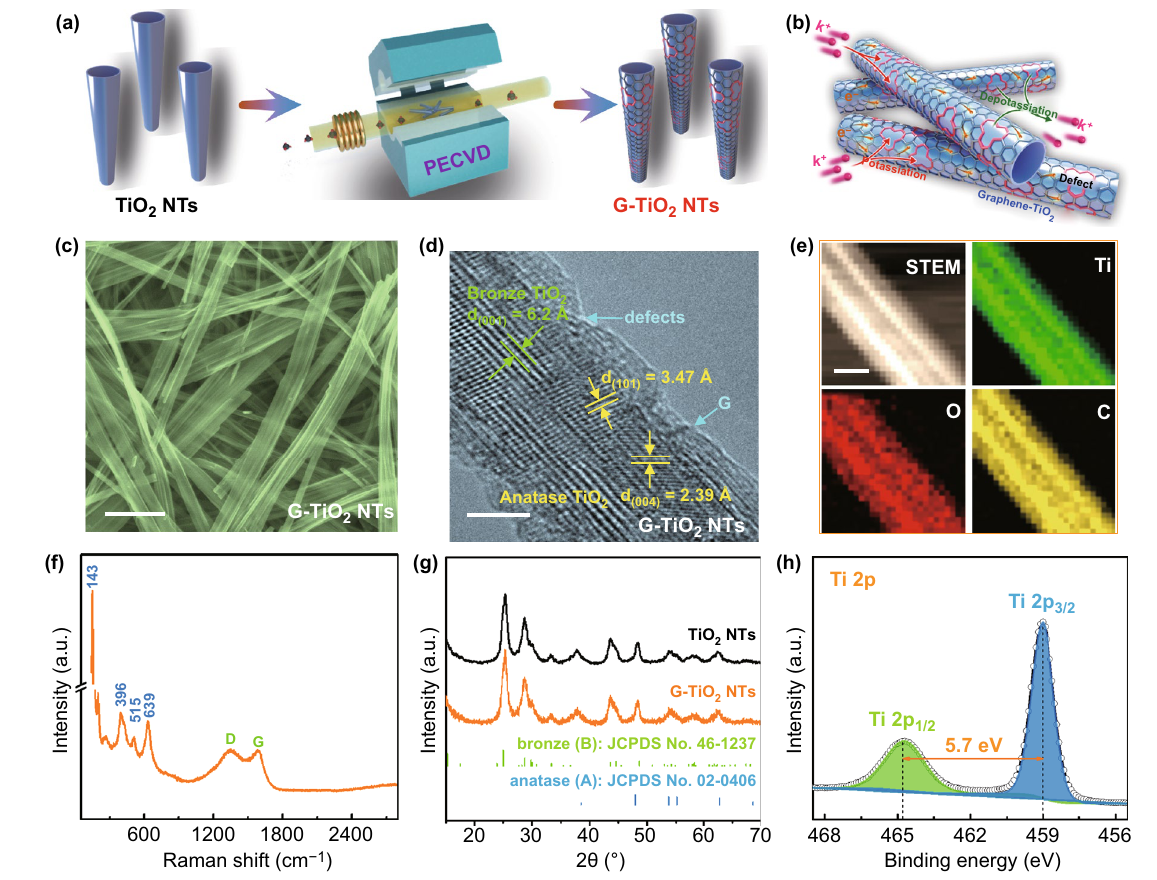
Fig. 1 Synthesis and characterization of G‑TiO 2 NTs. a Schematic illustration of the direct PECVD synthesis of G‑TiO 2 NTs. b A schematic showing electron/K‑ion transport within G‑TiO 2 NTs. c SEM and d HRTEM images of as‑prepared G‑TiO 2 NTs. e STEM image and corre‑ sponding elemental maps of G‑TiO 2 NTs. f Raman spectrum of G‑TiO 2 NTs. g XRD patterns of bare TiO 2 NTs and the PECVD‑derived G‑TiO 2 NTs. h XPS high‑resolution Ti 2p spectrum of G‑TiO 2 NTs. Scale bars: c 500 nm; d 5 nm; e 50